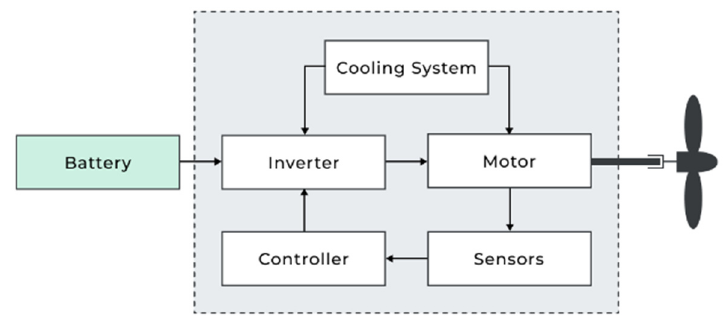
Figure 4. System overview of a typical lift/thrust unit for eVTOL aircraft.